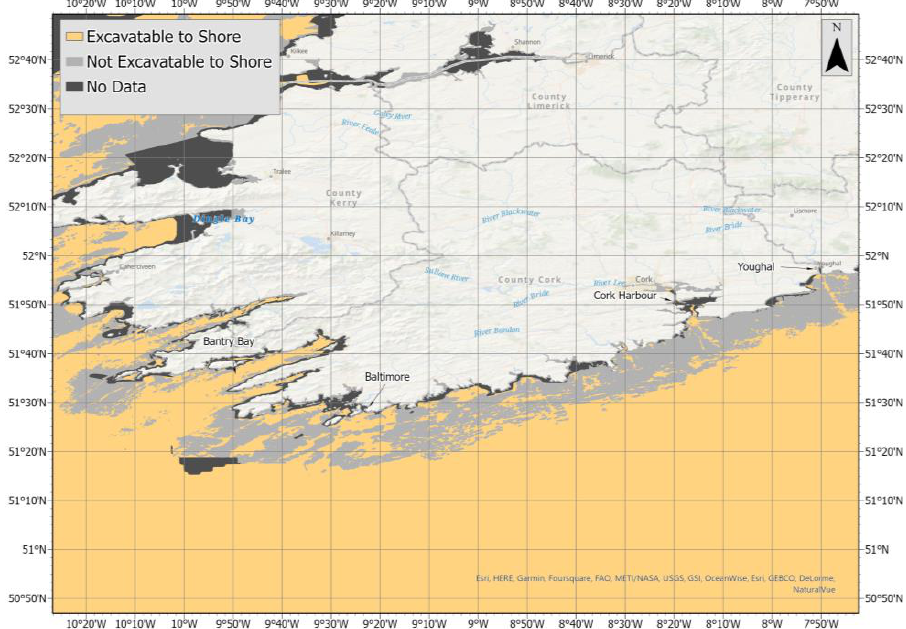
Figure 17. The excavation layer zoomed in on the Cork coast.